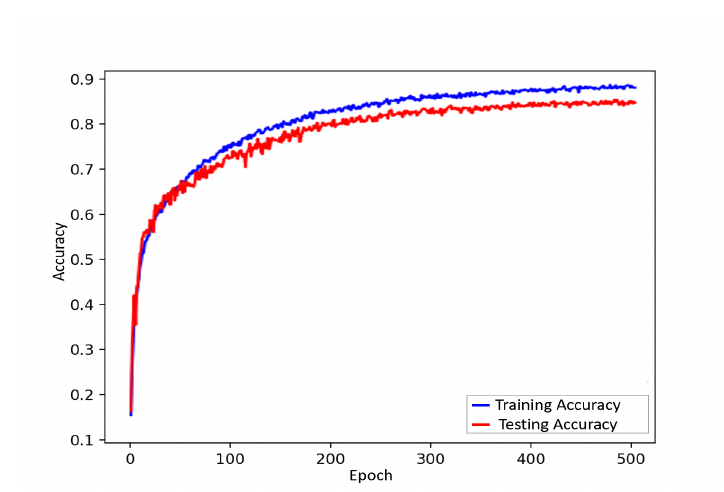
Figure 8. Test and training accuracy of the GAN model.